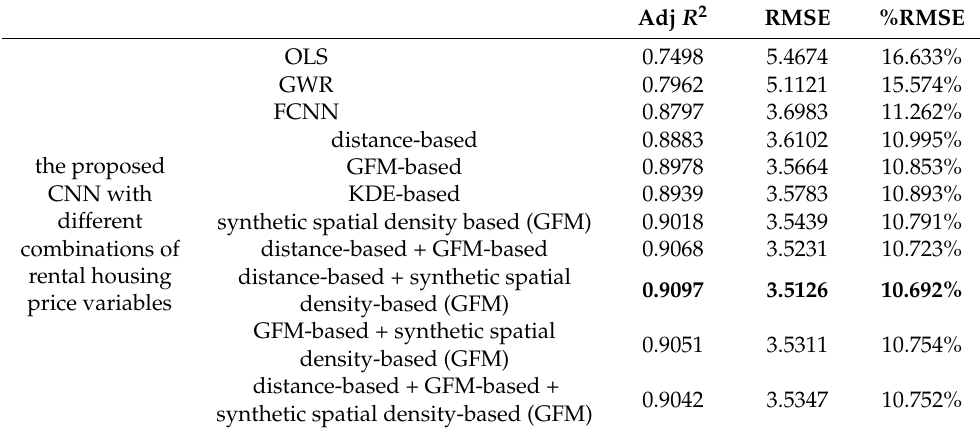
Table 5. Results of combinations of 2-dimensional rental housing price